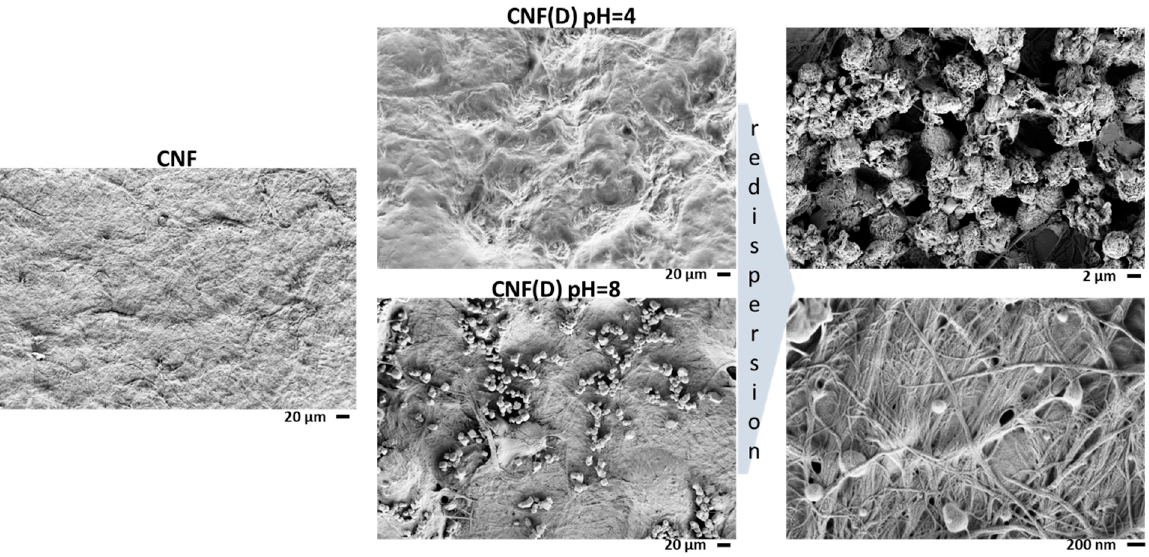
Figure 6. Field Emission Scanning Electron Microscopy (FE-SEM) images of CNF and CNF(D) at pH = 4 and pH = 8 reaction conditions before and after redispersion in Milli-Q water.